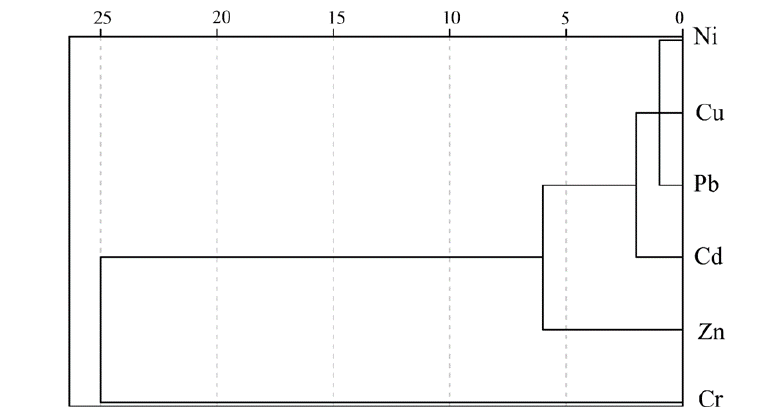
Figure 4. The cluster analysis of heavy metals among the studied cities.